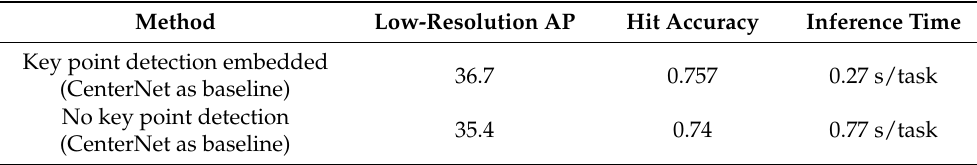
Table 4. Ablation Experiments on Key-point Detection.